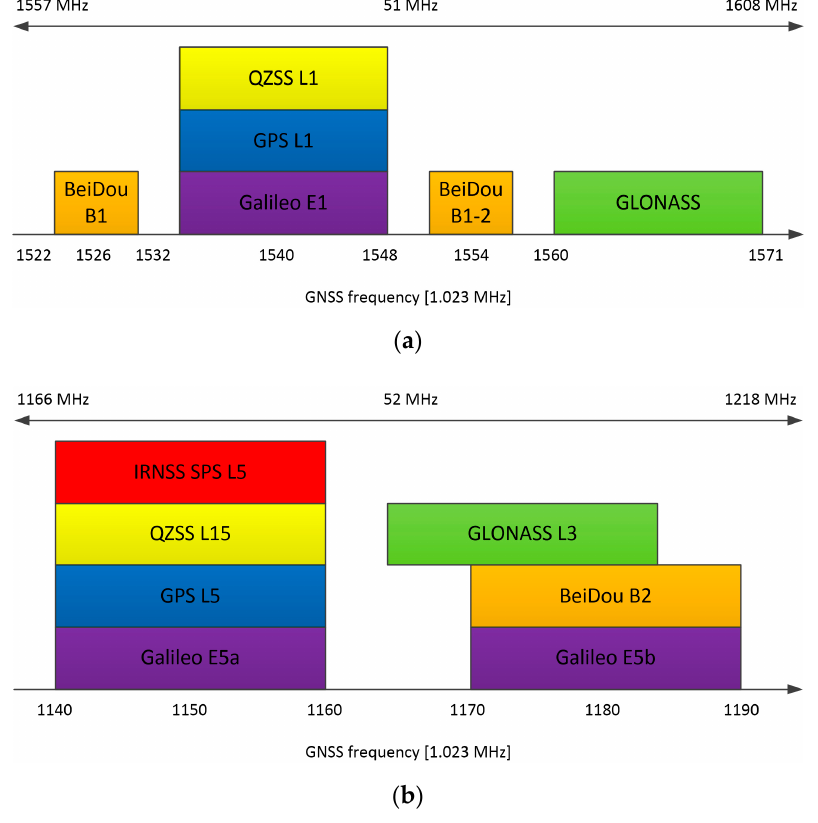
Figure 3. GNSS signals received and processed by the CCNV1-A1 chip: ( a ) L1/E1 band, ( b ) L5/E5 band.